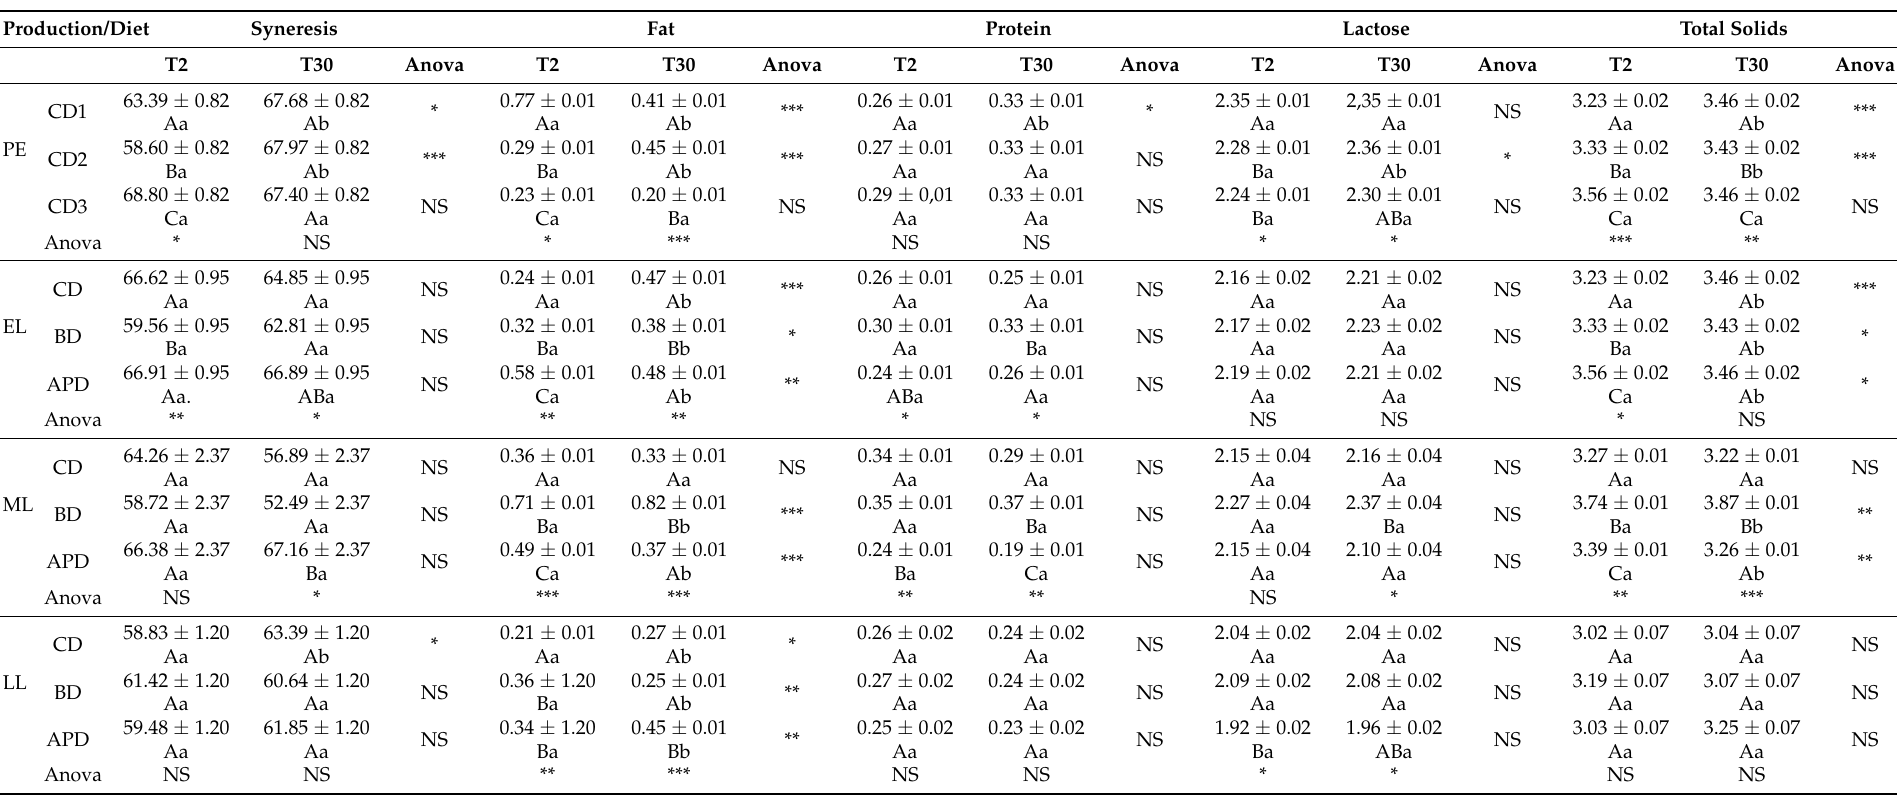
Table 7. Syneresis and main components (g/100 mL) of the expelled whey from fermented milk refrigerated at 4 ◦ C during 2 and 30 days using a mesophilic starter culture